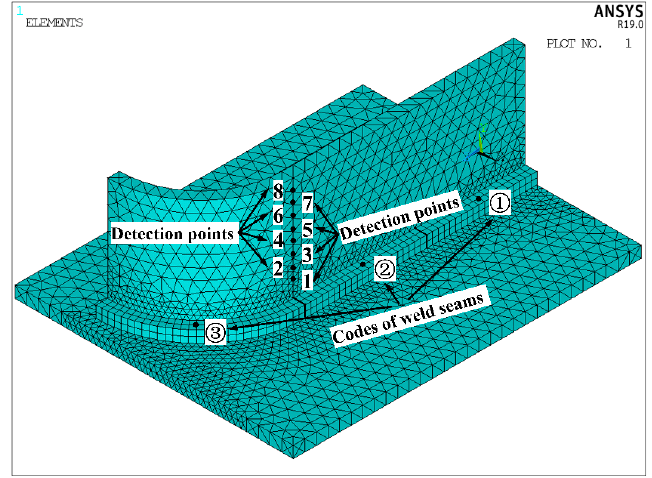
Figure 3. Finite element model of an arc weld seam.